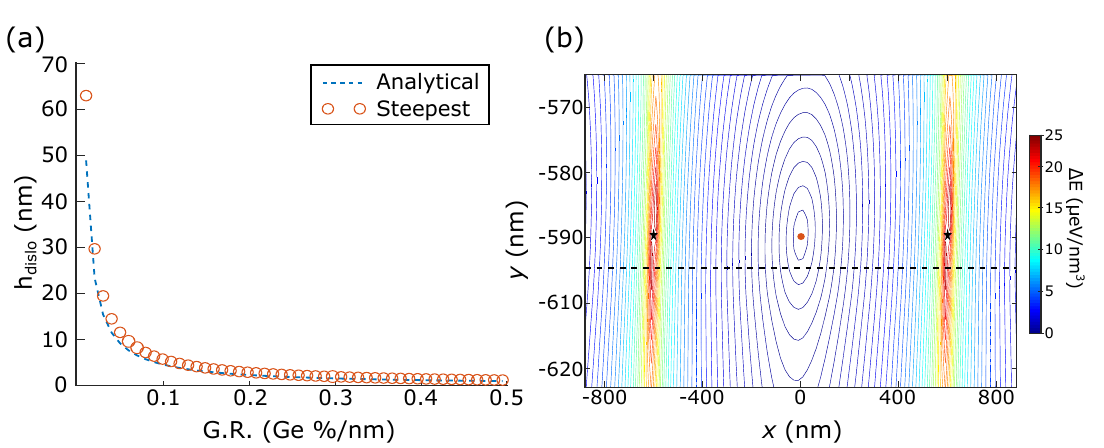
Figure 3. Position of the first dislocations introduced in the system ( a ). Comparison between the analytical model and the result of the steepest descent procedure. ( b ) Contour plot showing the minimum energy position for the second dislocation when periodic stress field expressions are